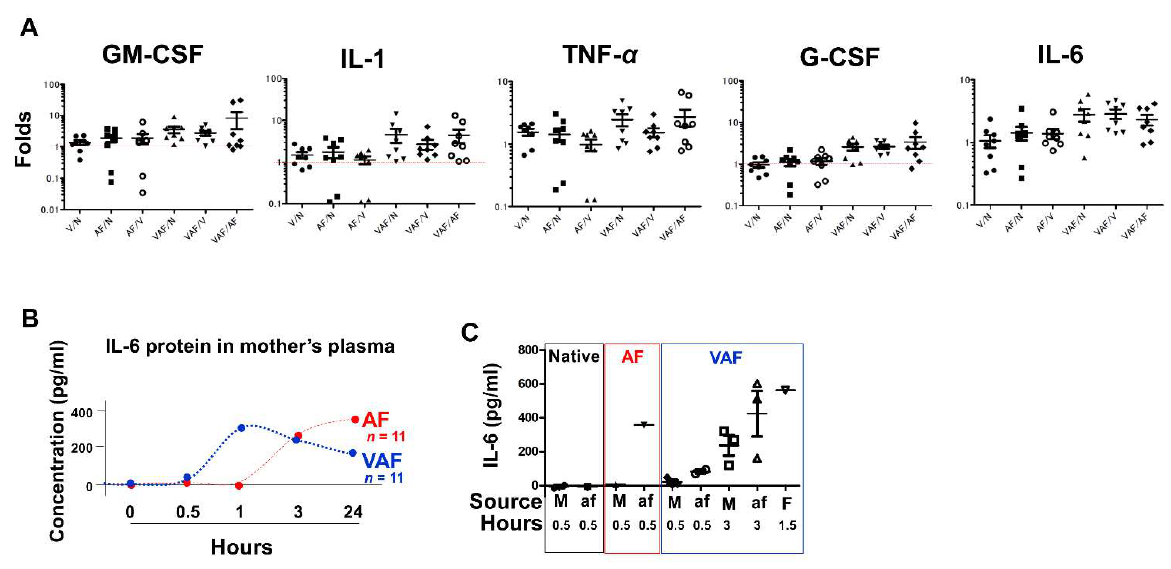
Figure 6. Cytokine expression measured by ELISA. ( A ) The relative folds of cytokine gene expression by comparing with the indicated conditions, V: vaginal; N: normal/native; AF: amniotic LPS; VAF: vaginal LPS plus amniotic LPS. Hprt is a housekeeping gene used as a control. ( B ) IL-6 protein in the maternal plasma (M) was measured at each endpoint time (0–24 h) after amniotic LPS exposure. Either saline injection into the amniotic fluid, or the vaginal LPS group, were used as control samples to compare with the AF (red) or VAF (blue) groups, respectively (for detailed information refer to raw data). ( C ) IL-6 concentration in M plasma and amniotic fluid (af) at the indicated time. Fetal plasma (F) represents a mixture derived from 12 fetuses from 3 dams.